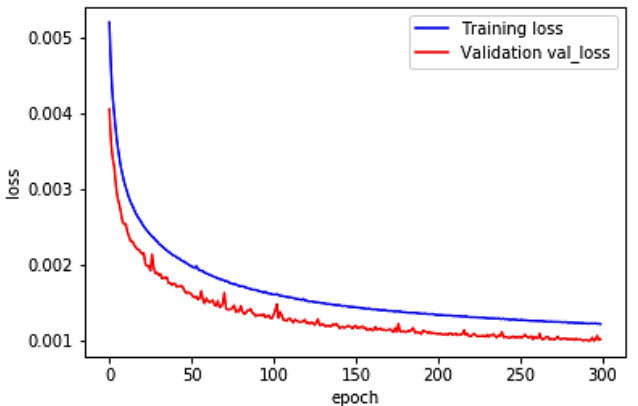
Figure 5. The training loss function of the super-resolution